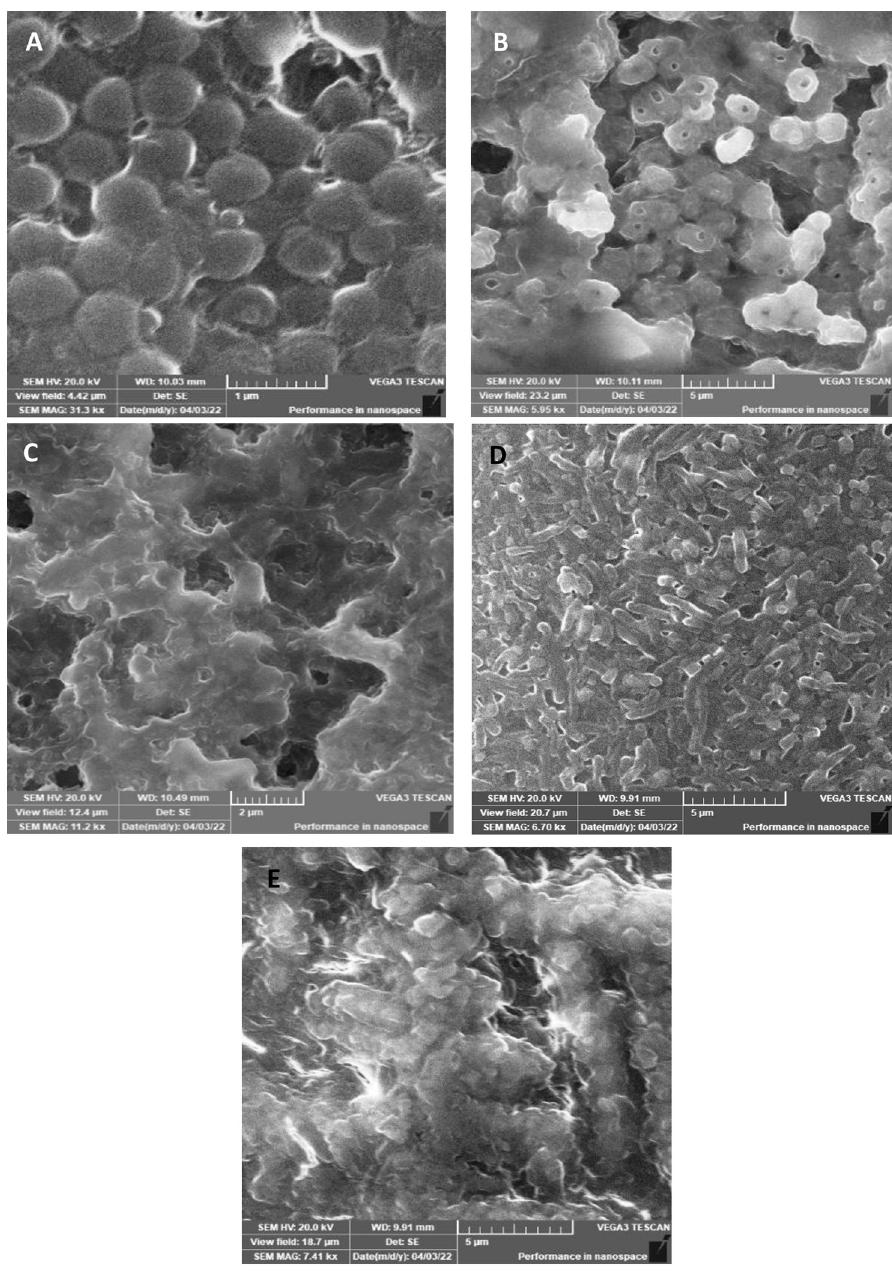
Fig 5. SEM micrographs of the Gram-positive pathogenic bacterium S . aureus subsp. aureus Rosenbach ATCC 25923 (Panel A represents the control while Panels B and C represent the treated cells) and the Gram-negative pathogenic bacterium S . boydii ATCC 9207 (Panel D represents the control, while Panel E represents the treated cells).